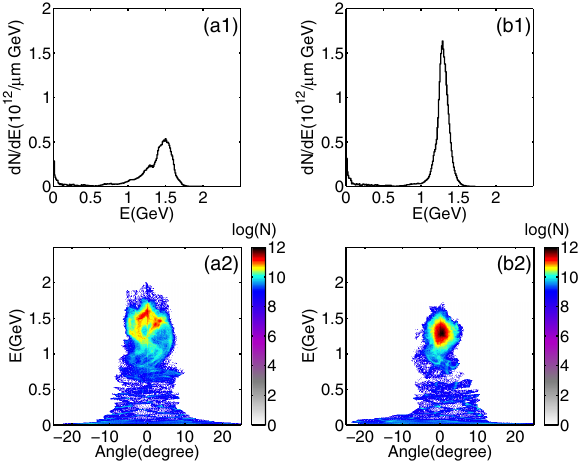
FIG. 5. The energy spectra of the proton in the single laser case (a1) and two lasers case (b1). The energy angular distributions of the proton in the single laser case (a2) and two lasers case (b2). Here, we choose those protons who locate in the region − 4 μ m ≤ y ≤ 4 μ m as the objects of statistics. These snapshots are corresponding to the moment t ¼ 42 T L .